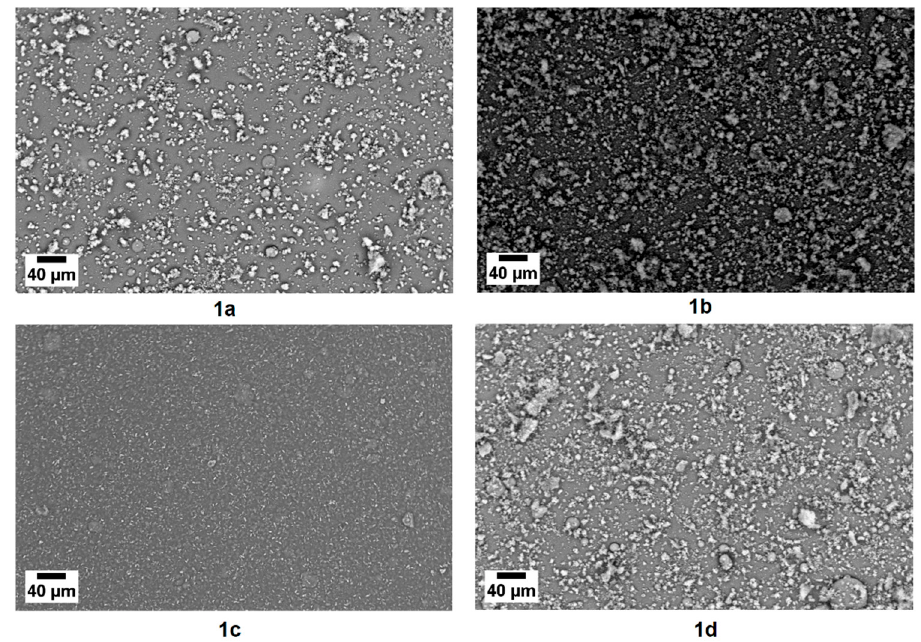
Figure 6. Microphotographs of films of heptacoordinated organotin (IV) complexes at 500×.